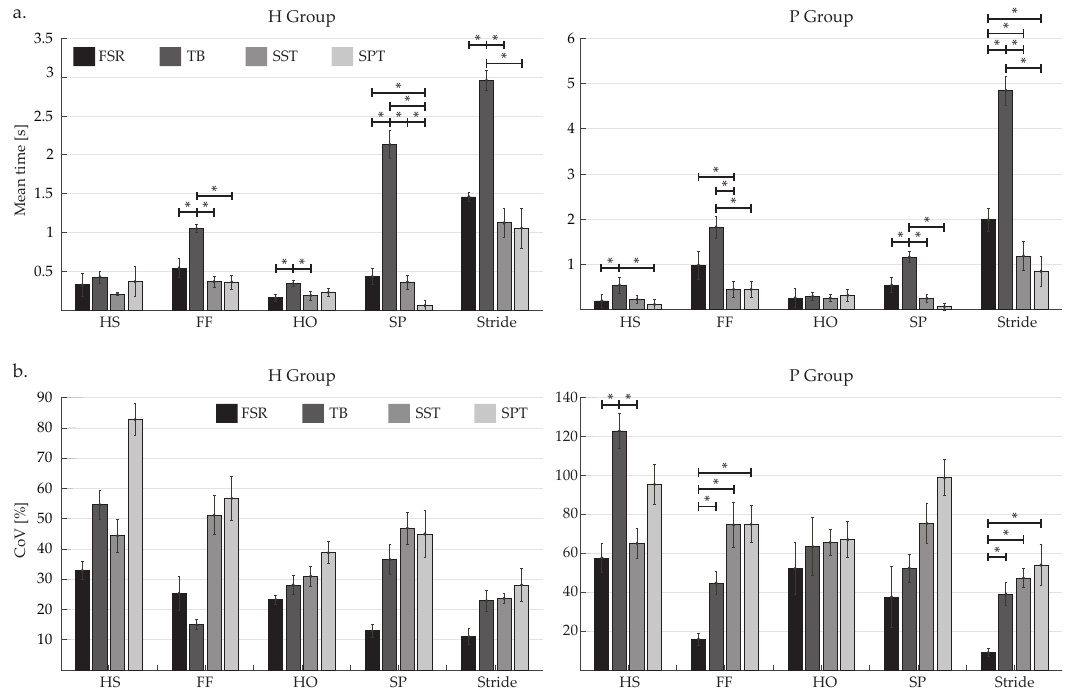
Figure 8. ( a ) Mean time (MT); and ( b ) Coefficient of variation (CoV) evaluated for stride and each gait phase for the reference system (FSR), and each detection algorithm: threshold-based (TB) and HMM-based algorithm, both using subject-specific training (SST) and standardized parameter training (SPT). The left bar chart corresponds to the results of healthy subjects (H), and the right graph to those of pathological subjects (P). Asterisks denote statistically significant differences (Bonferroni, p < 0.05). Values of ICC for MT and CoV are included in Table 4. The results indicate that ICC was almost always in the range of good or excellent reliability, with the exception of a few values related to the TB algorithm that showed poor